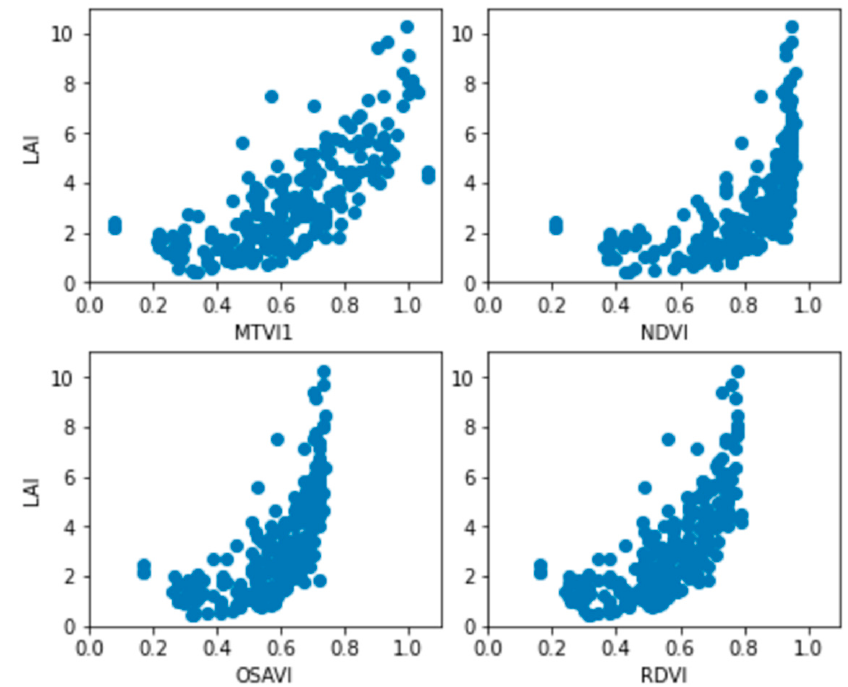
Figure 2. Leaf area index (LAI) in association with four different vegetation indices of interest for barley. MTVI1, NDVI, OSDVI, and RDVI represent the modified triangular vegetation index 1, normalised difference vegetation index, optimised soil-adjusted vegetation index, and re-normalised difference vegetation index, respectively.